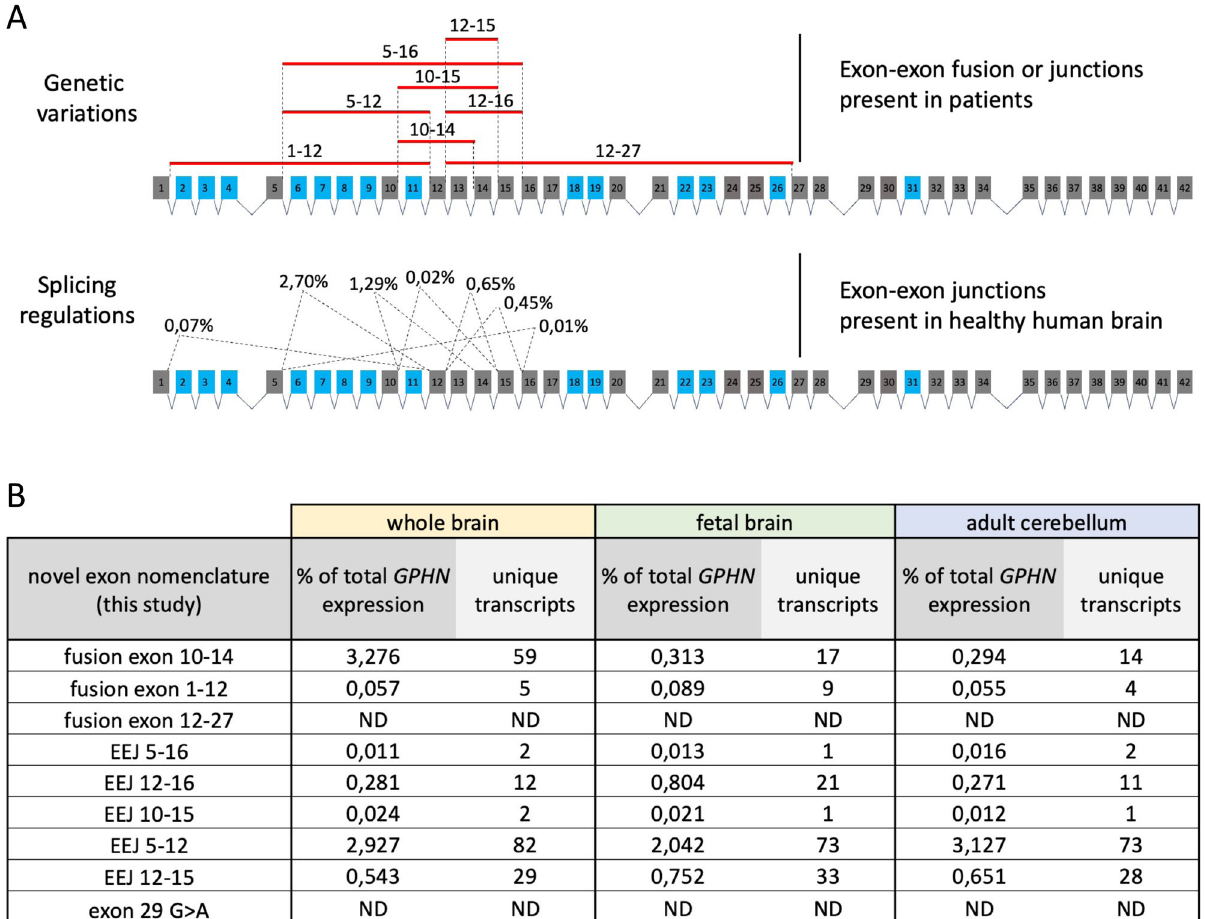
Fig. 8 Expression of pathological GPHN transcripts is repressed in the healthy human brain. A Schematic representation of genetic variations found in patients (upper panel) and the corresponding spliced exon-exon junctions identi fi ed by this study in the healthy human brain samples (lower panel). Percentages of each splicing event indicated the average detection in the adult entire brain, fetal entire brain, and adult cerebellum. B Table summarizing the detection of each exon-exon junctions in brain samples, and the number of unique transcripts containing